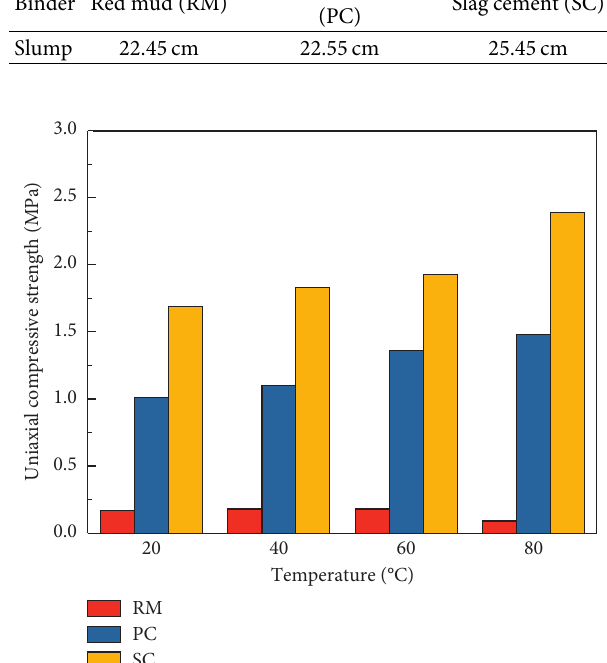
Figure 3: Effect of binder type and temperature on the UCS of CPB after curing for 4hours.